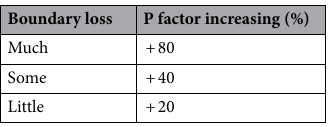
Table 2. Boundary loss values proposed in this research.